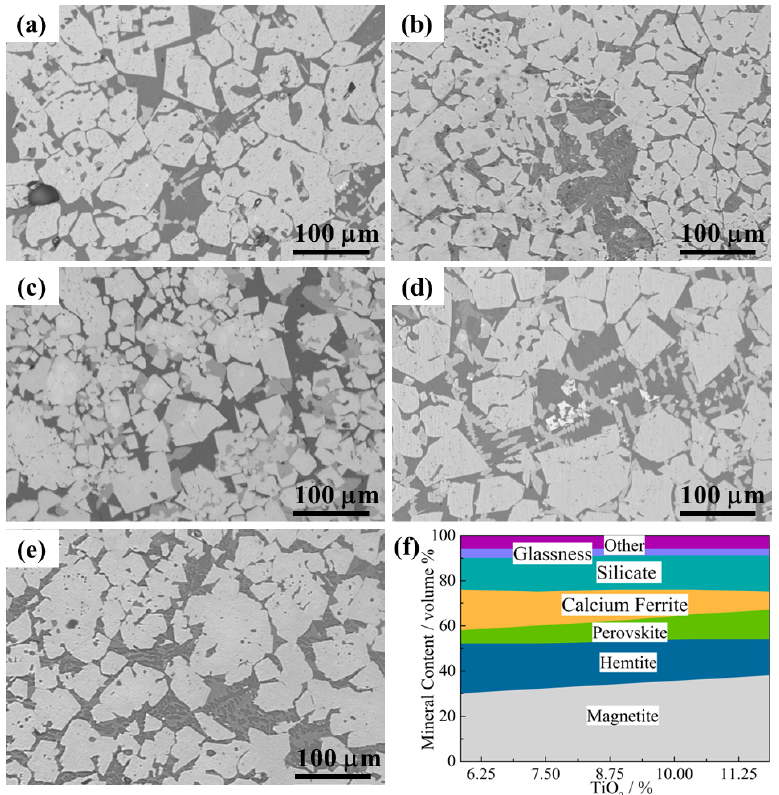
Figure 6. Microstructure of CVTM sinter with different TiO 2 content. ( a ) TiO 2 = 5.85%; ( b ) TiO 2 = 7.35%; ( c ) TiO 2 = 8.85%; ( d ) TiO 2 = 10.35%; ( e ) TiO 2 = 11.85%; ( f ) Mineral content.